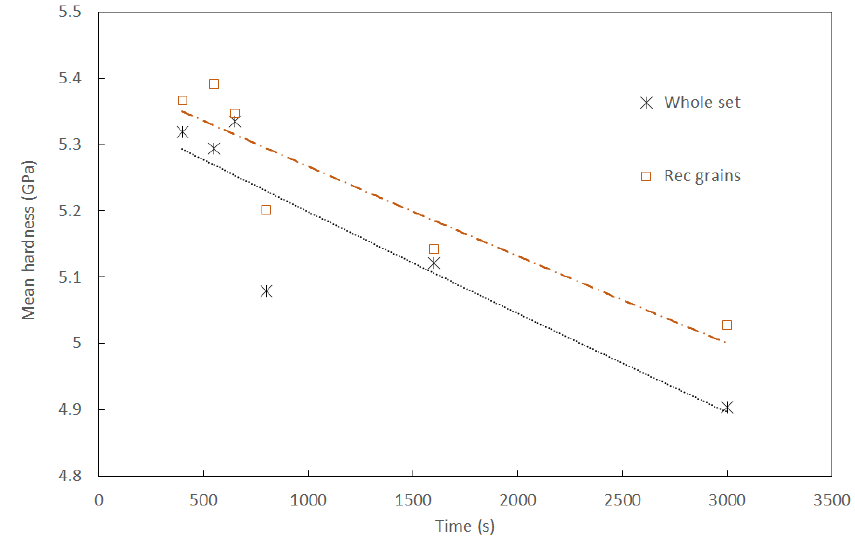
Figure 8. Mean hardness versus time for the whole set of grains or restricted to the recovered